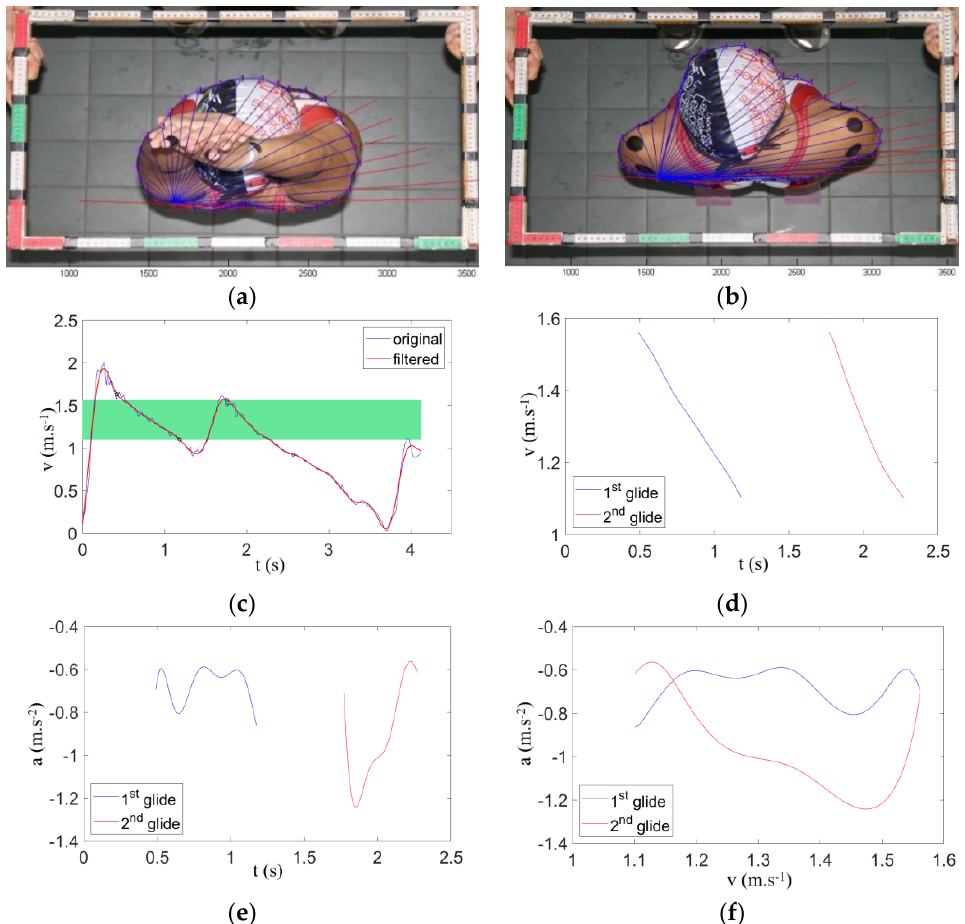
Figure 3. Hydrodynamic data collecting and processing. Body surface area was determined using the first ( a ) and second ( b ) gliding positions, and the v(t) data ( c ) was filtered with a 3 Hz cut-off low-pass fourth order Butterworth filter. The v(t) curve range of two successive gliding phases ( d ), the acceleration-to-time curve (a(t)) ( e ) and the acceleration-to-velocity curves ((a(v)) ( f ) are also displayed.